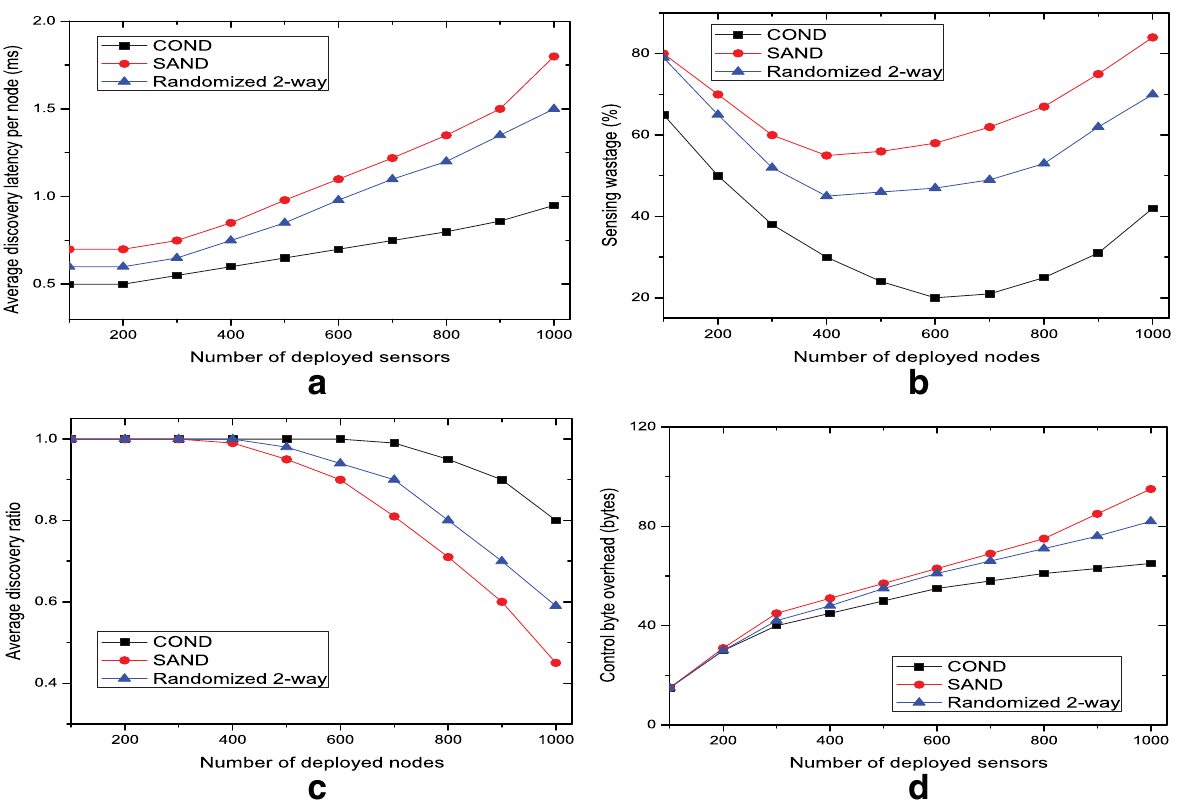
Fig. 6 Impacts of number of sensor nodes on performances of the studied neighbor discovery algorithms. a Average discovery latency. b Sensing wastage of discovery slots. c Average discovery ration. d Control byte